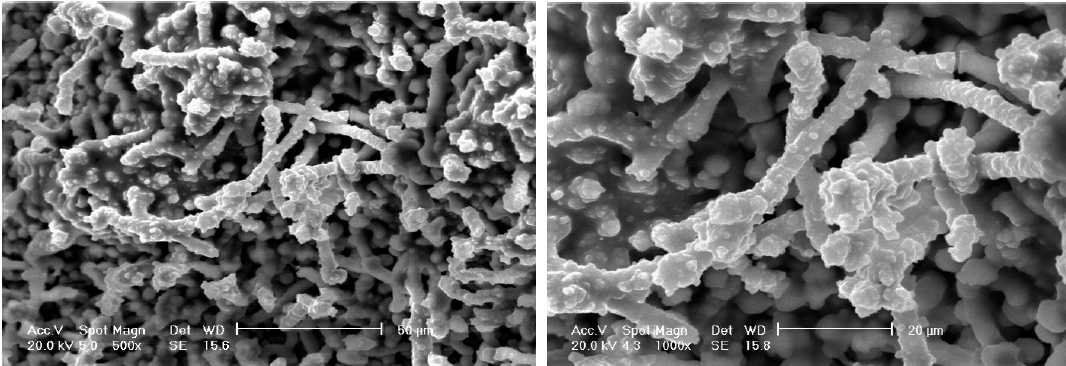
Figure 14. Corrosion products development after reactivation of SRB due to inoculation of the corroded tube cuts in the SRB-specific media (Images are from similar features with different magnifications)